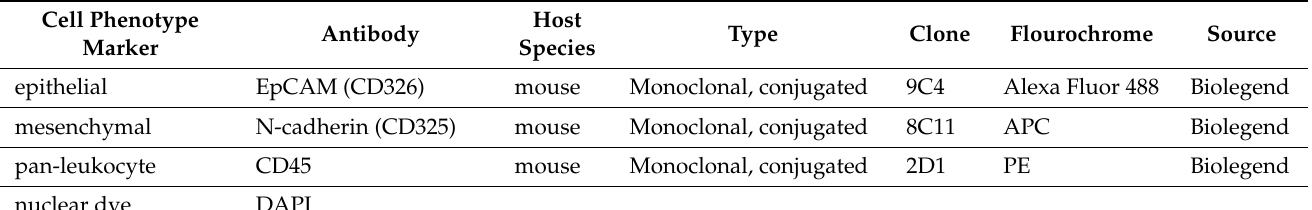
Table 1. Antibody panel optimised for detection of CTCs enriched using Parsortix having been collected in Transfix blood collection tubes (PE—phycoerythrin, APC—Allophycocyanin). Cell